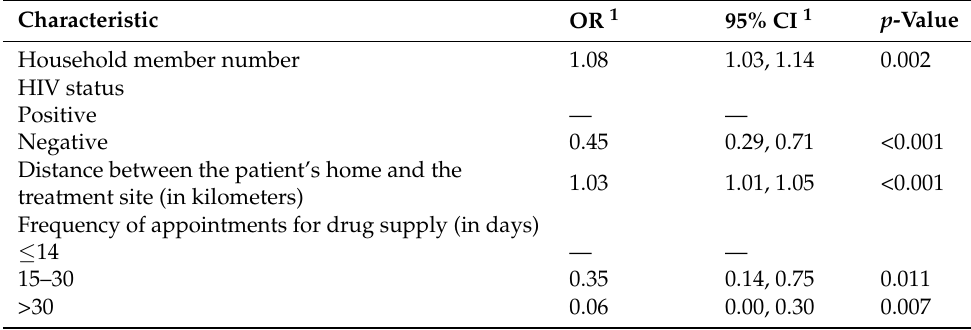
Table 7. Multinomial logistic regression between stress and sociodemographic and clinical